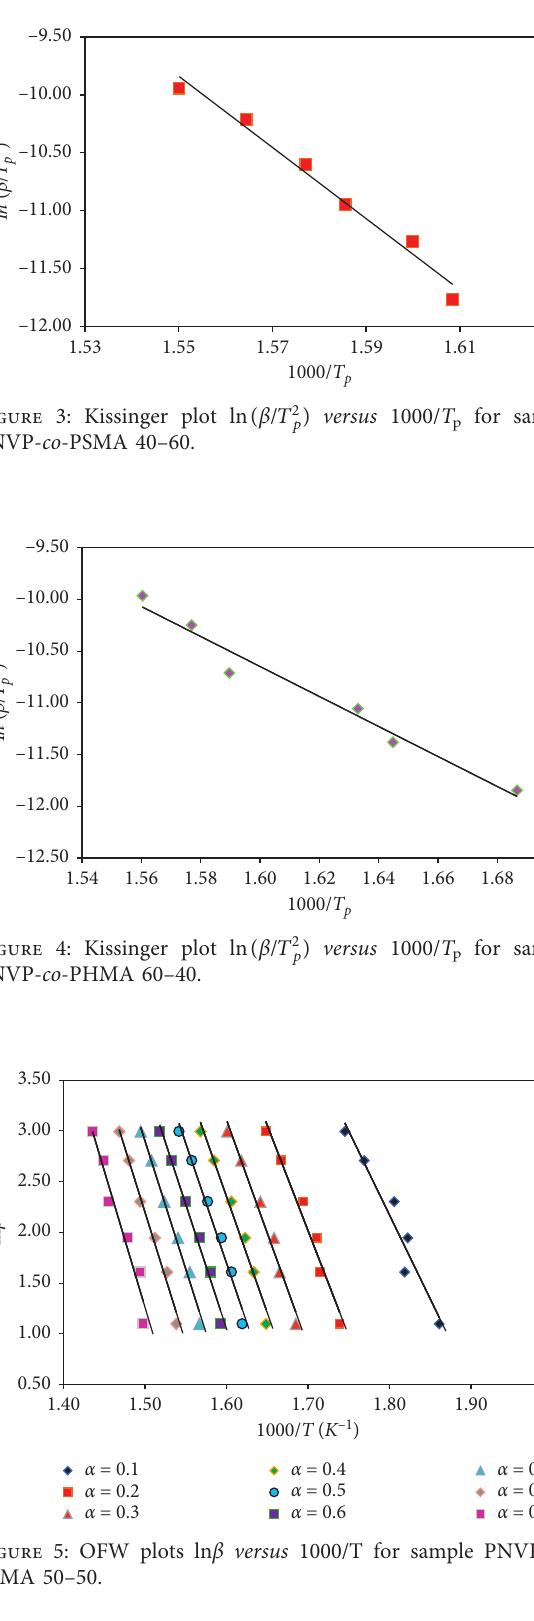
Figure 5: OFW plots ln β versus 1000/ Τ for sample PNVP- co - PSMA